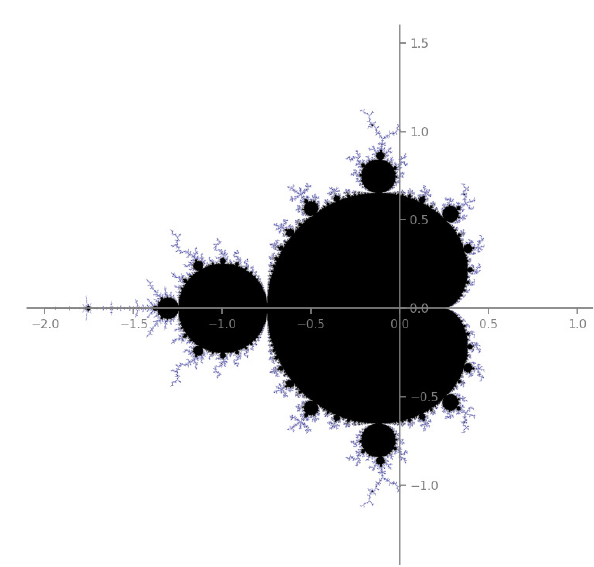
Figure 1. The Mandelbrot set M in the complex